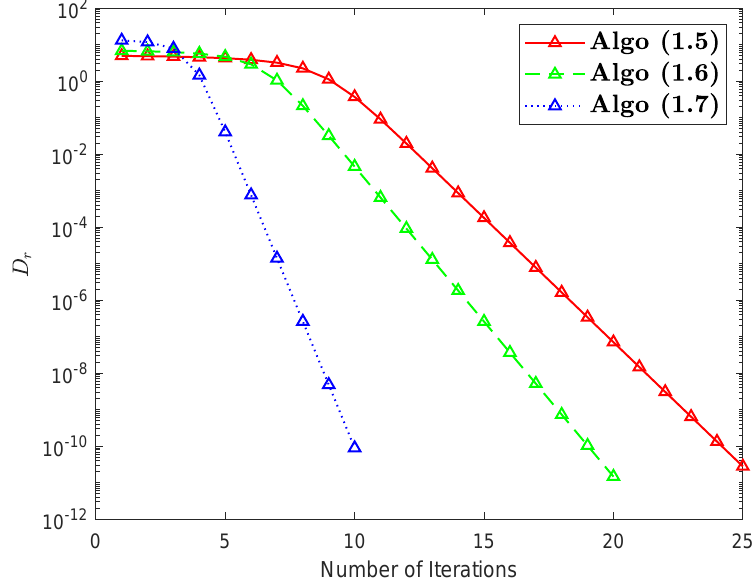
Figure 5. A graphical comparison of Algorithms (5)–(7), where z 1 =